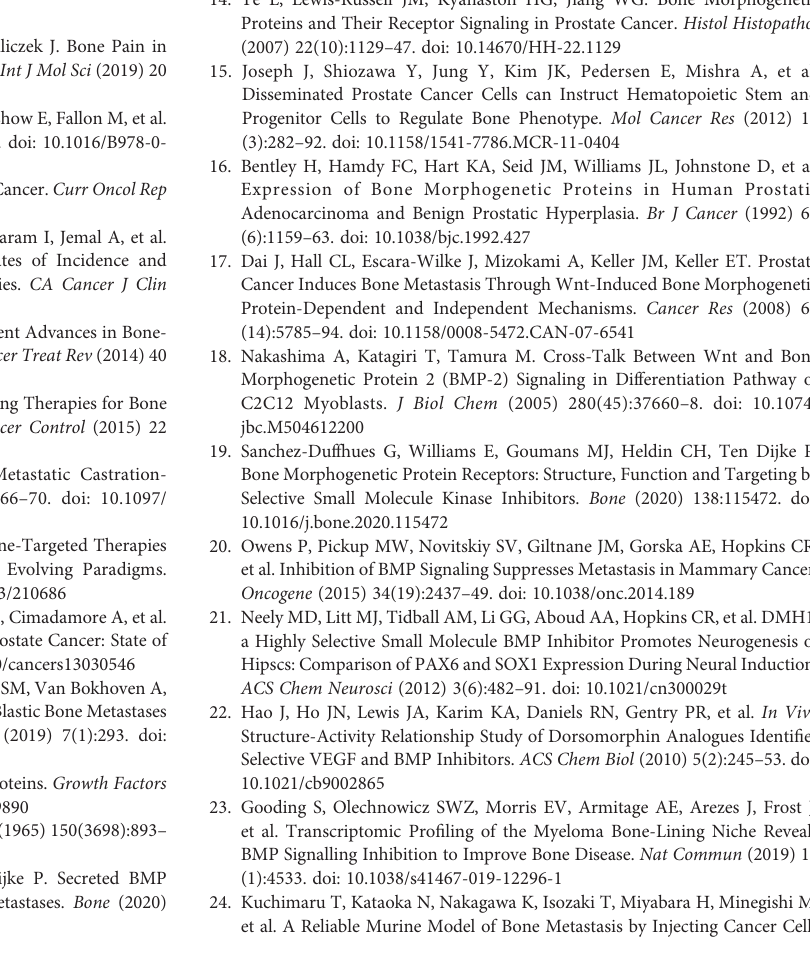
Statistical signi fi cance was determined using Mann-Whitney U test and error bars indicating